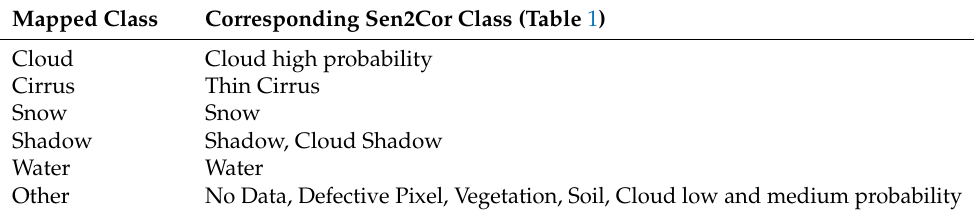
Table 4. Class Mapping of Extended Dataset for Sen2Cor Assessment. Mapped Class Corresponding Sen2Cor Class (Table 1